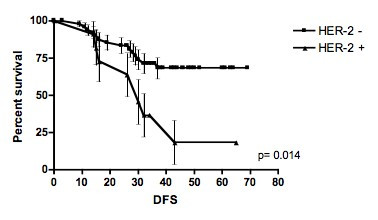
Kaplan-Meyer curve for DFS in sixty patients subjected to Neoadjuvant chemotherapy with docetaxel and epirubicin according to HER-2 protein expression.